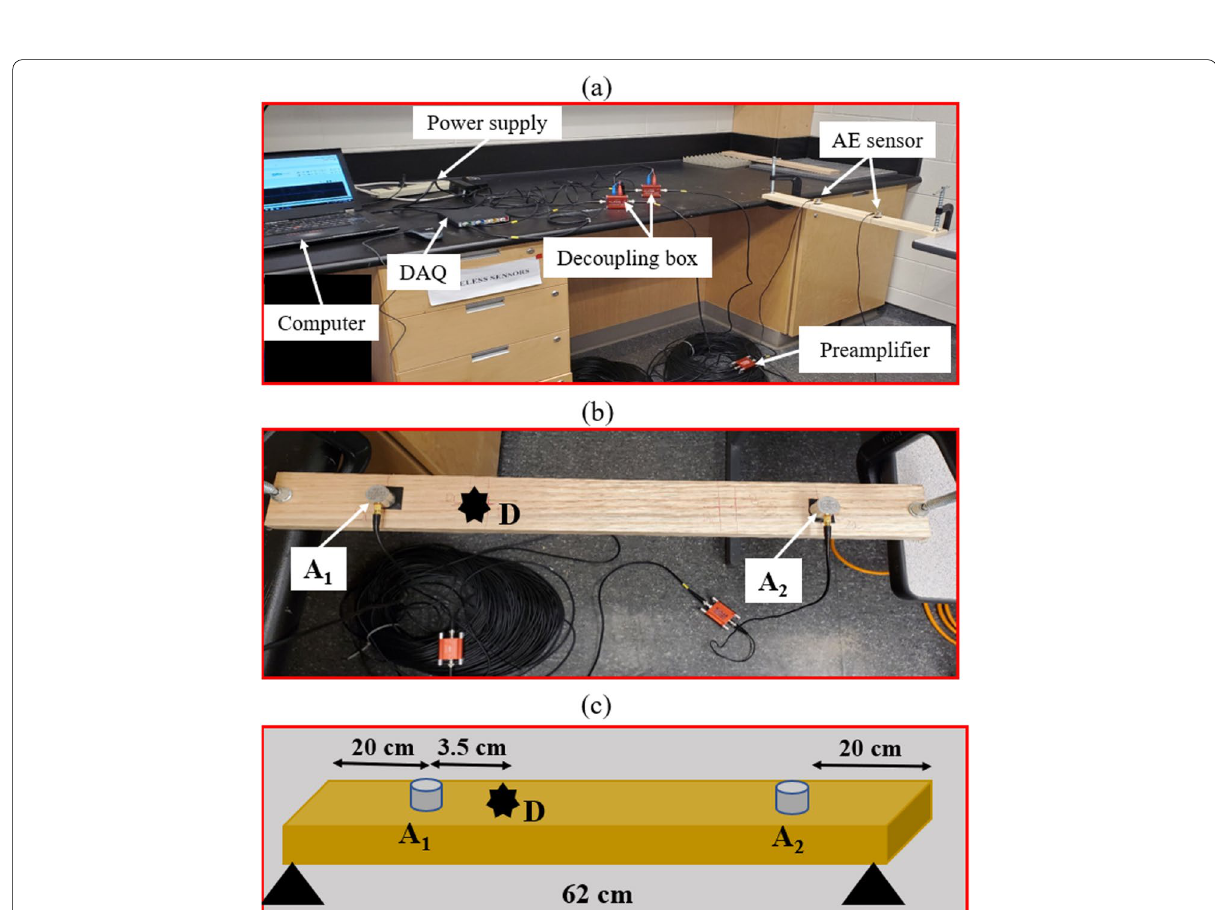
Fig. 8 ( a ) AE monitoring system and the experimental setup: ( b ) actual and ( c )